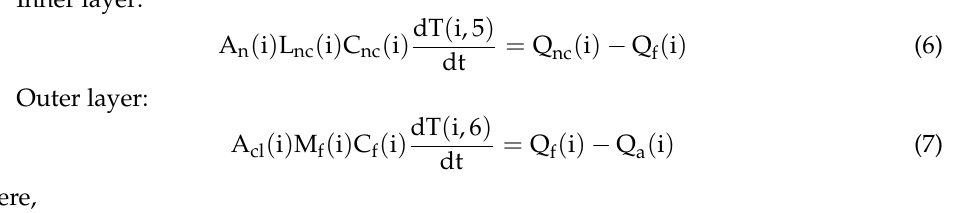
Figure 2. Human body-clothing-environment interaction system.